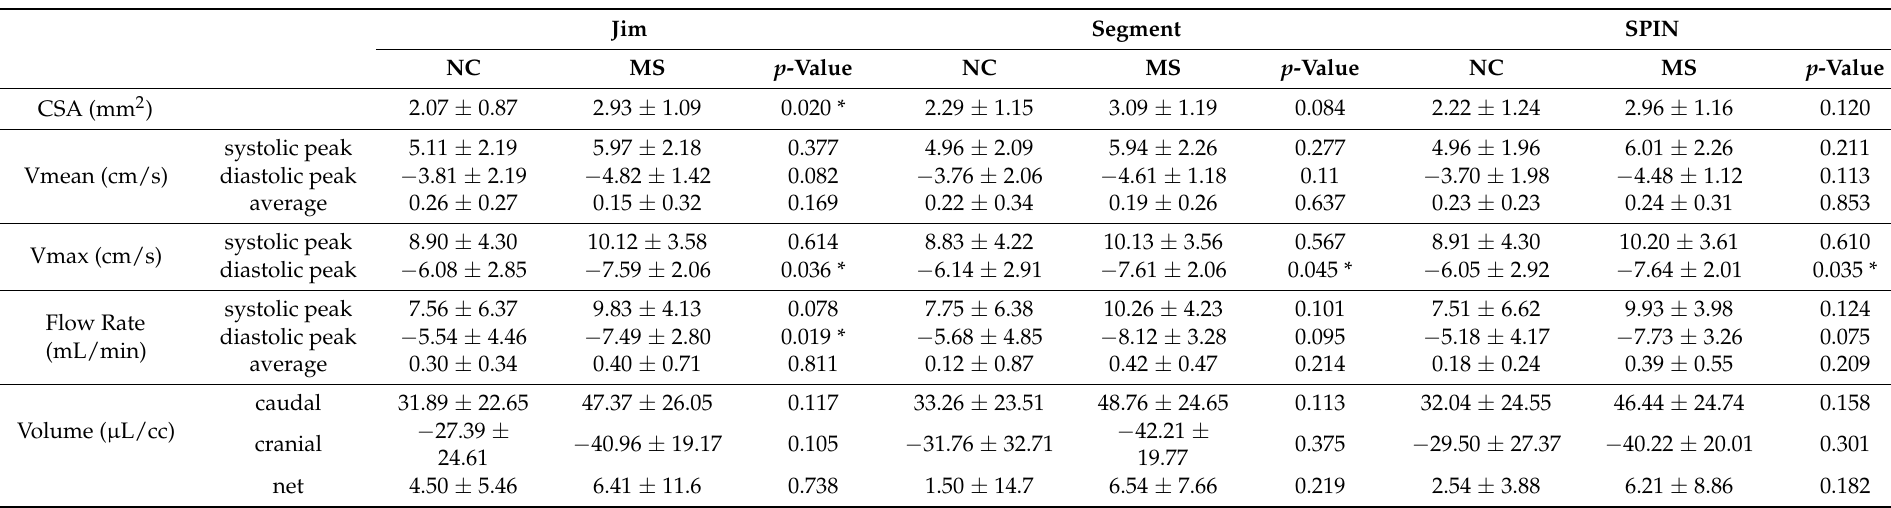
Table 5. PC-derived variables, compared between groups using a general linear model covaried for age and sex. The pair-wise corrected comparisons are